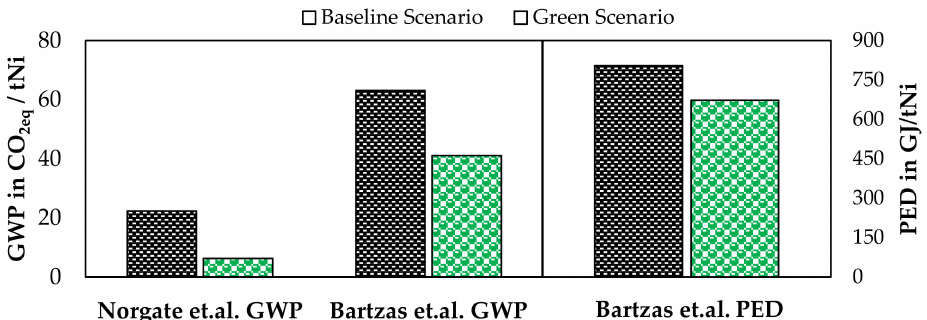
Figure 13. GWP and PED of the pyrometallurgical nickel production using fossil and bio-based carbon (based on Data by